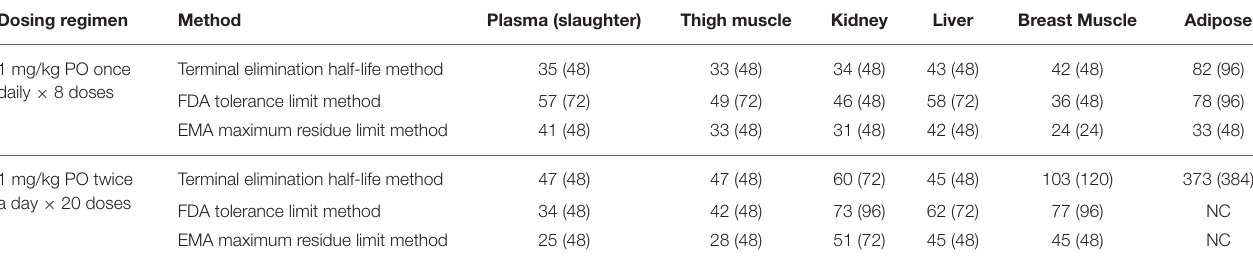
TABLE 6 | Estimated extra-label drug use (ELDU) withdrawal intervals (WDIs) for meloxicam administered orally via two dosing regimens in chickens. Dosing regimen Method Plasma (slaughter) Thigh muscle Kidney Liver Breast Muscle Adipose 1 mg/kg PO once Terminal elimination half-life daily × 8 doses